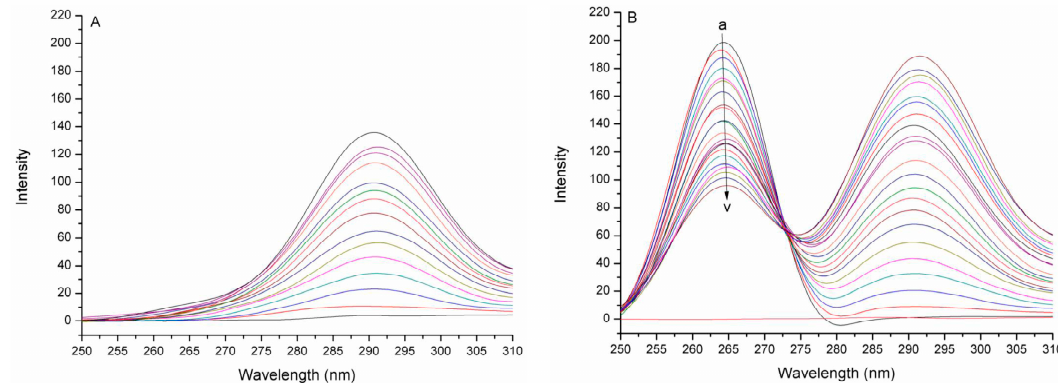
Figure 3. The fluorescence quenching spectra of JW-3 by the subunit H of V-ATPase at 298 K and pH 6.8. ( A ) In the absence of JW-3; ( B ) In the constant concentration of JW-3 (6.578 × 10 − 5 M). The concentration of the protein changed from a to v (10 − 7 M): 0, 0.67, 2.00, 3.32, 4.62, 5.90, 7.17, 8.42, 9.66, 10.88, 12.08, 13.27, 14.45, 15.61, 16.75, 17.89, 19.00, 20.11, 21.20, 22.29, 23.35, 24.41.